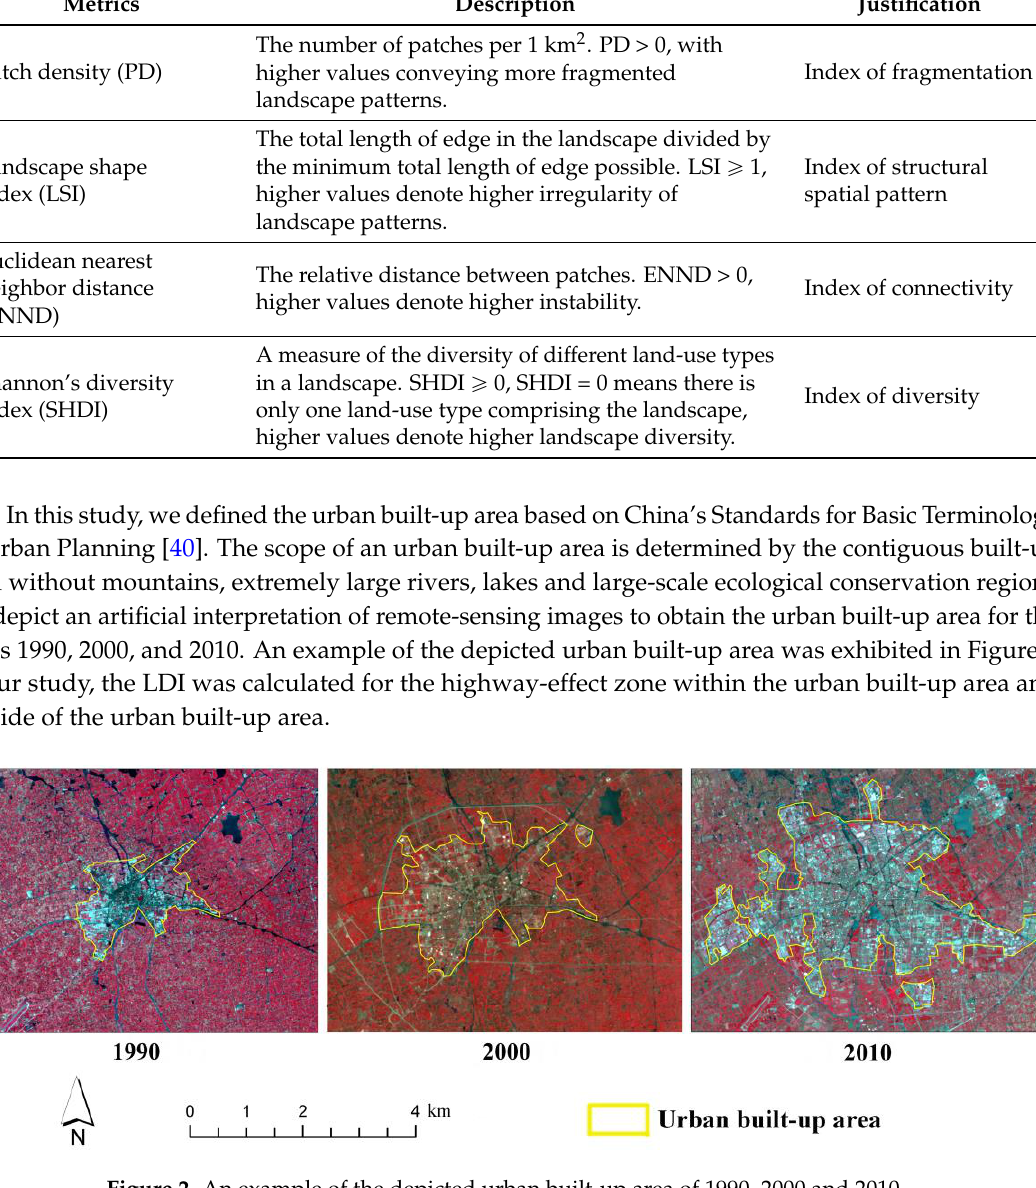
Table 1. Landscape metrics and their ecological characteristics.